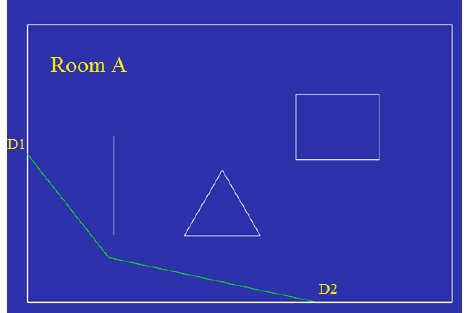
Figure 7. The shortest path between D1 and D2 in Room A